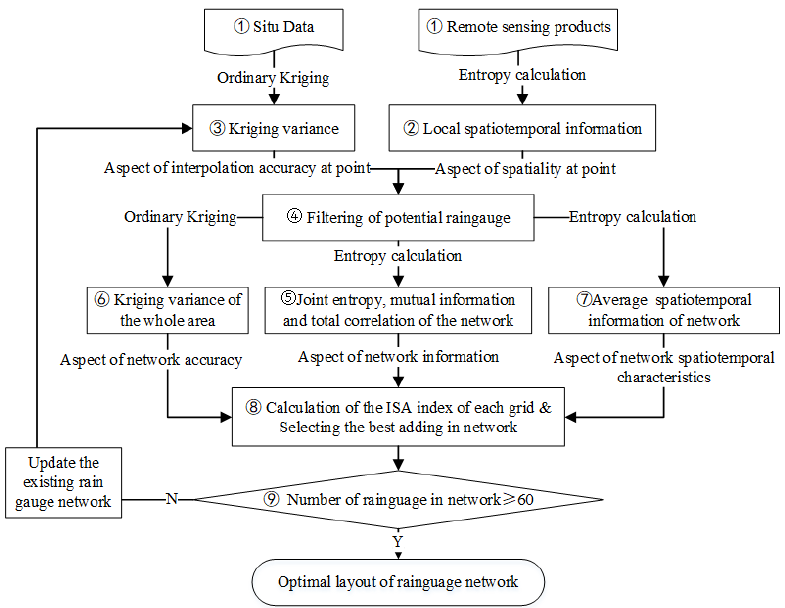
Figure 4. Flowchart for the optimal design of a rain gauge network. ISA, information content, spatiotemporality, and accuracy.